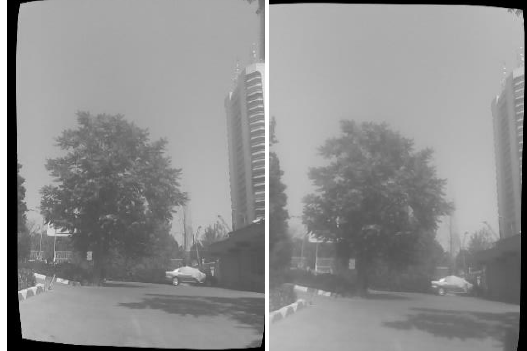
Figure 6. Left: left_image_raw right: right_image_raw: The raw images from each camera